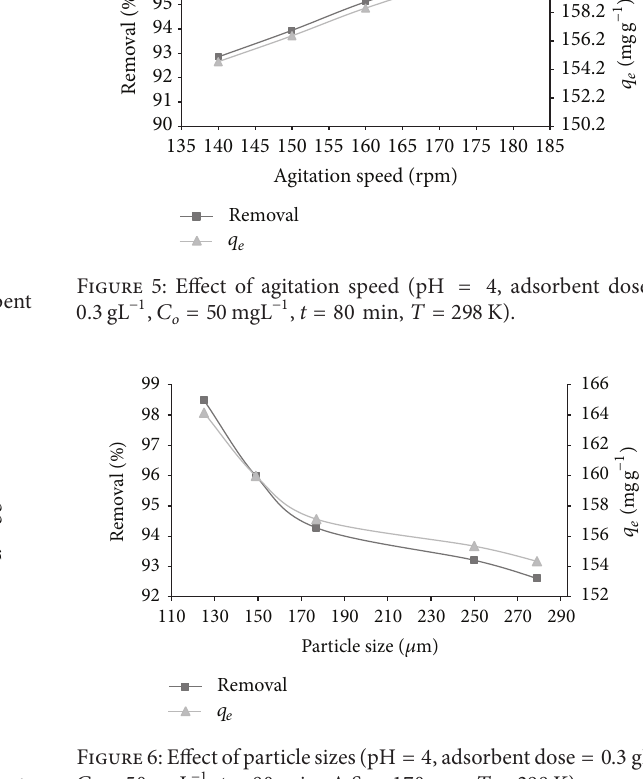
Figure 4: Effect of contact time (pH = 4 , adsorbent dose = 0.3 gL −1 , = 50 mL −1 , A . S . = 150 rpm, 𝑇 = 298 K). 𝐶 𝑜